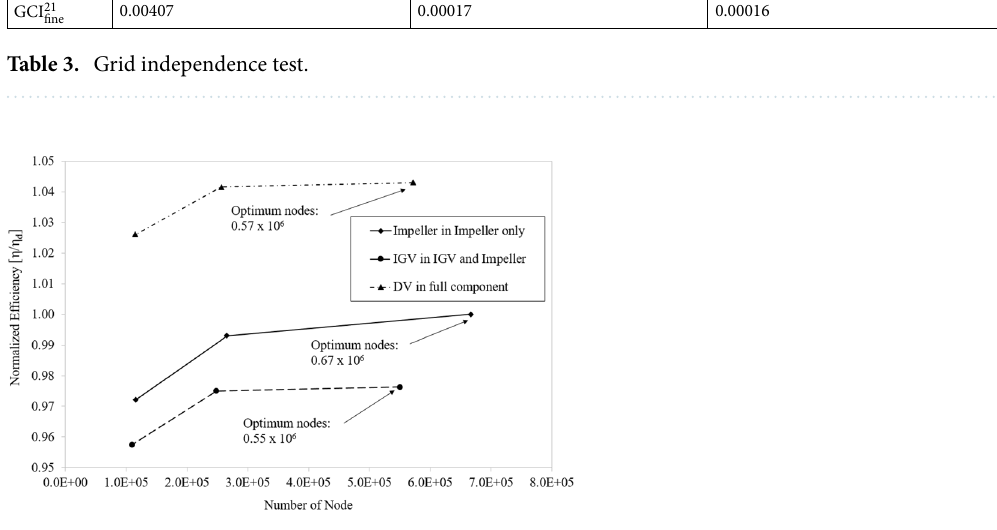
Figure 7. Comparison of efficiency for different grid